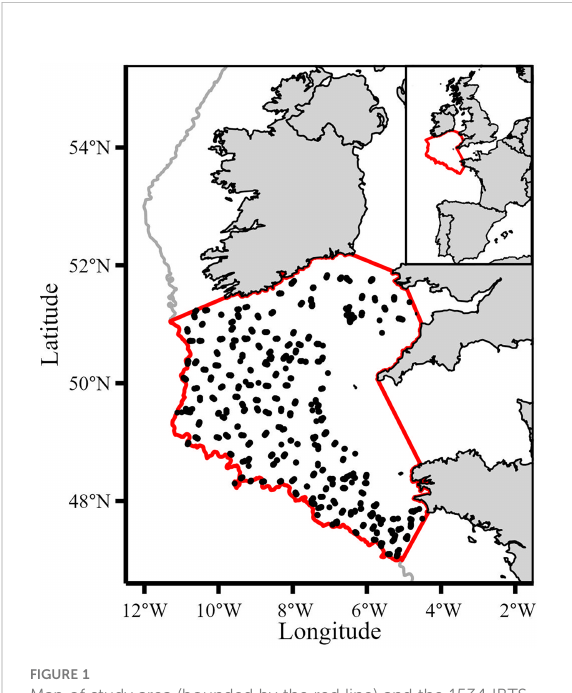
FIGURE 1 Map of study area (bounded by the red line) and the 1534 IBTS haul locations used (black points). Grey line denotes 200m